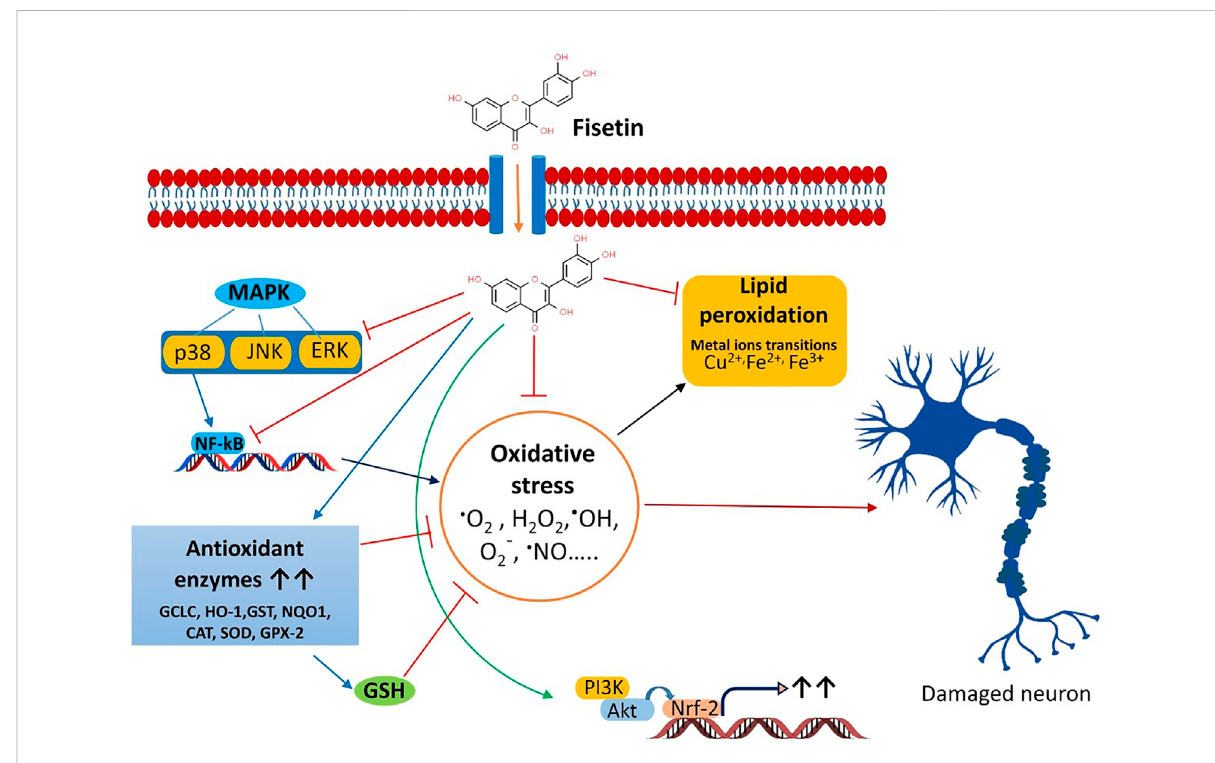
FIGURE 3 OS pathogenicity in neurodegenerative disease and the protevtive effects of fi